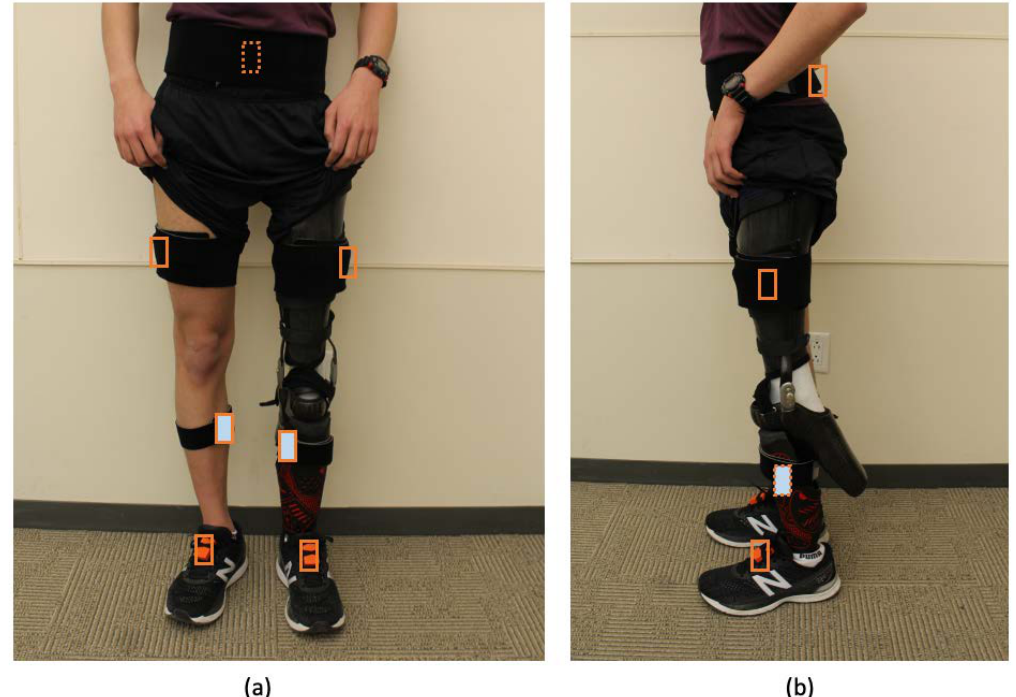
Figure 1. LLPU participant equipped with the Xsens MVN suit: ( a ) frontal view; ( b ) sagittal view. Sensors were attached to the feet (middle of the bridge of foot), lower leg (flat on the shin bone, medial surface of the tibia, approximately 5 cm below the patella), upper leg (middle of the lateral thigh, above the knee), and pelvis (flat on the sacrum) [32]. Solid and dashed outlines represent visible and not visible sensors, respectively. Lower-leg sensors (highlighted by filled light blue boxes) were used for validating the proposed GED algorithm.